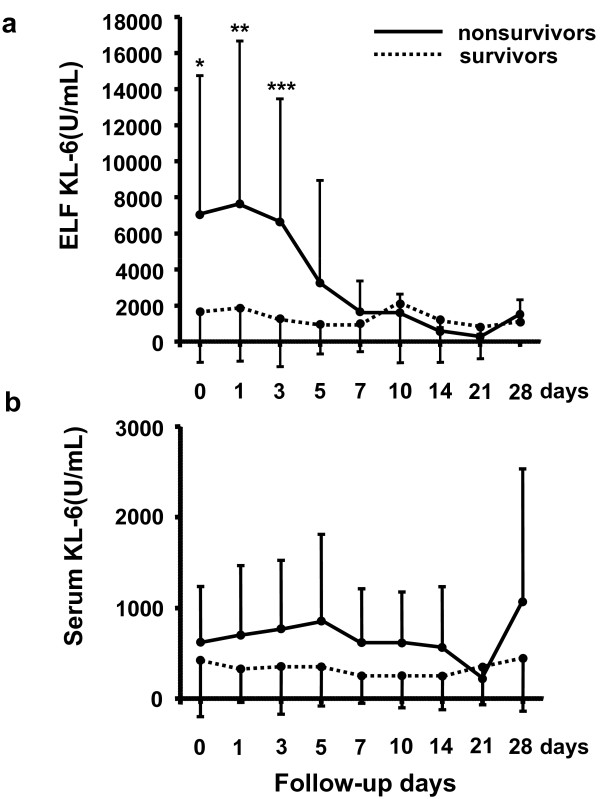
Kinetics of KL-6 levels in ELF (a) and serum (b) in the nonsurvivors (n = 10) and survivors (n = 22). Data are means ± SD. *p = 0.0087, **p = 0.0421, ***p = 0.0324 by Mann-Whitney U-test. A significant reducing trend in ELF levels of KL-6 was observed in the nonsurvivors (p = 0.0318 by test for linear trend).